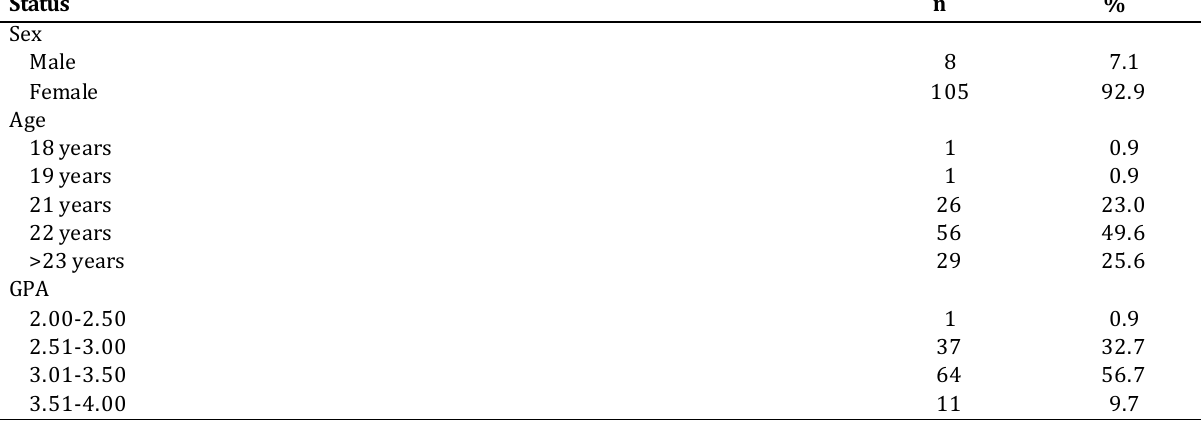
Table 1. Personal characteristics of 4 th year nursing students (n = 113) Status